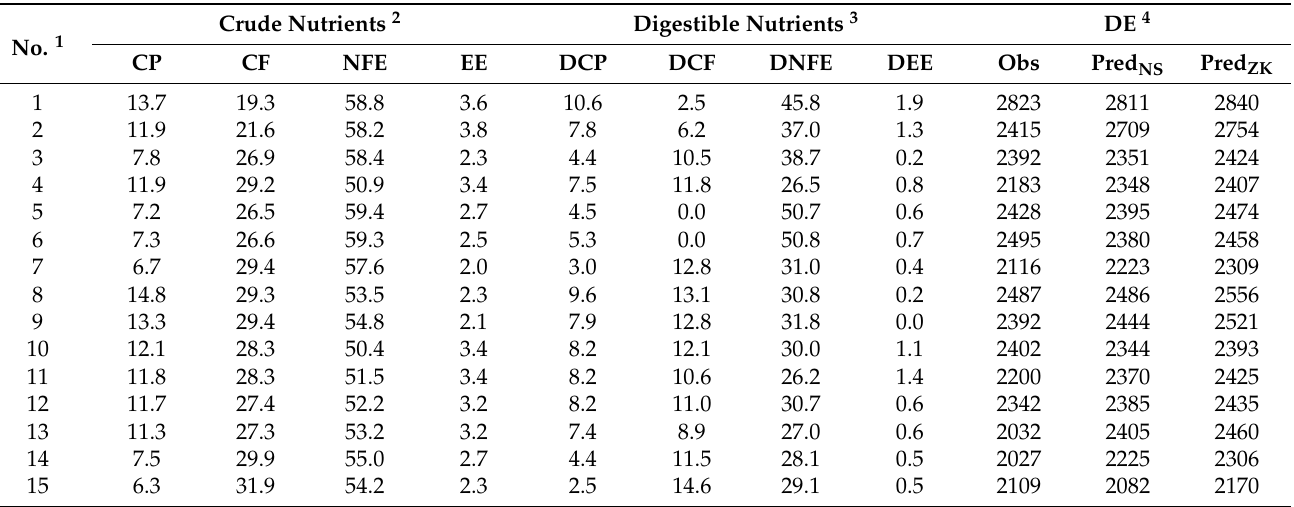
Table 1. Crude nutrient composition (%), digestible nutrient composition (%) and observed and predicted digestible energy content (kcal/kg) of the mixed feeds and diets included in the evaluation. All values on dry matter